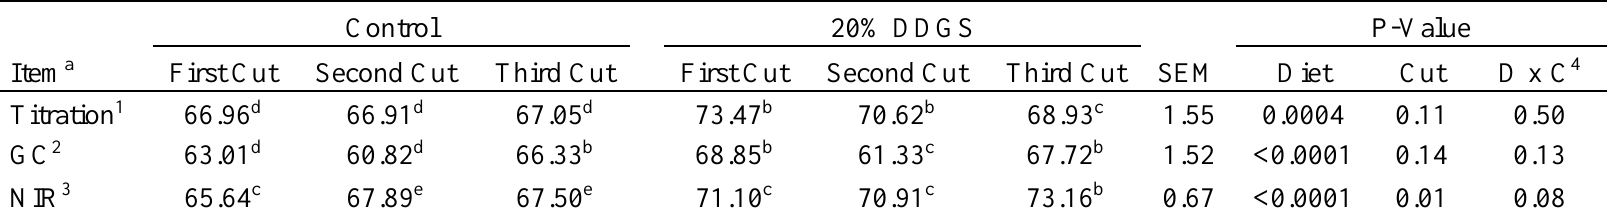
Table 6. Least squares means for iodine values of belly fat determined by three different methods of